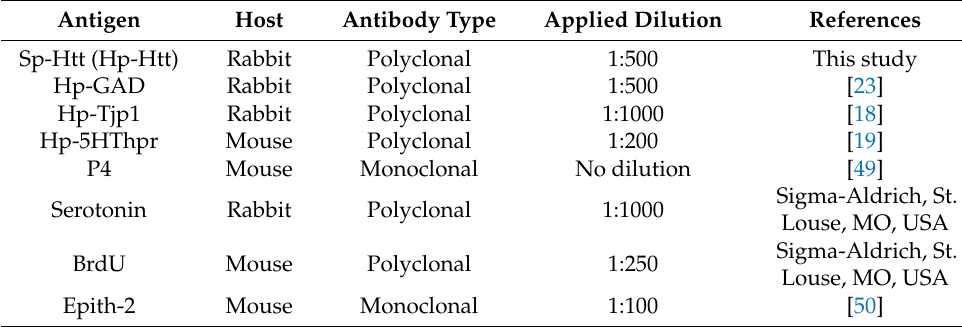
Table 1. The list of primary antibodies used in this study. Host Antibody Type Applied Dilution